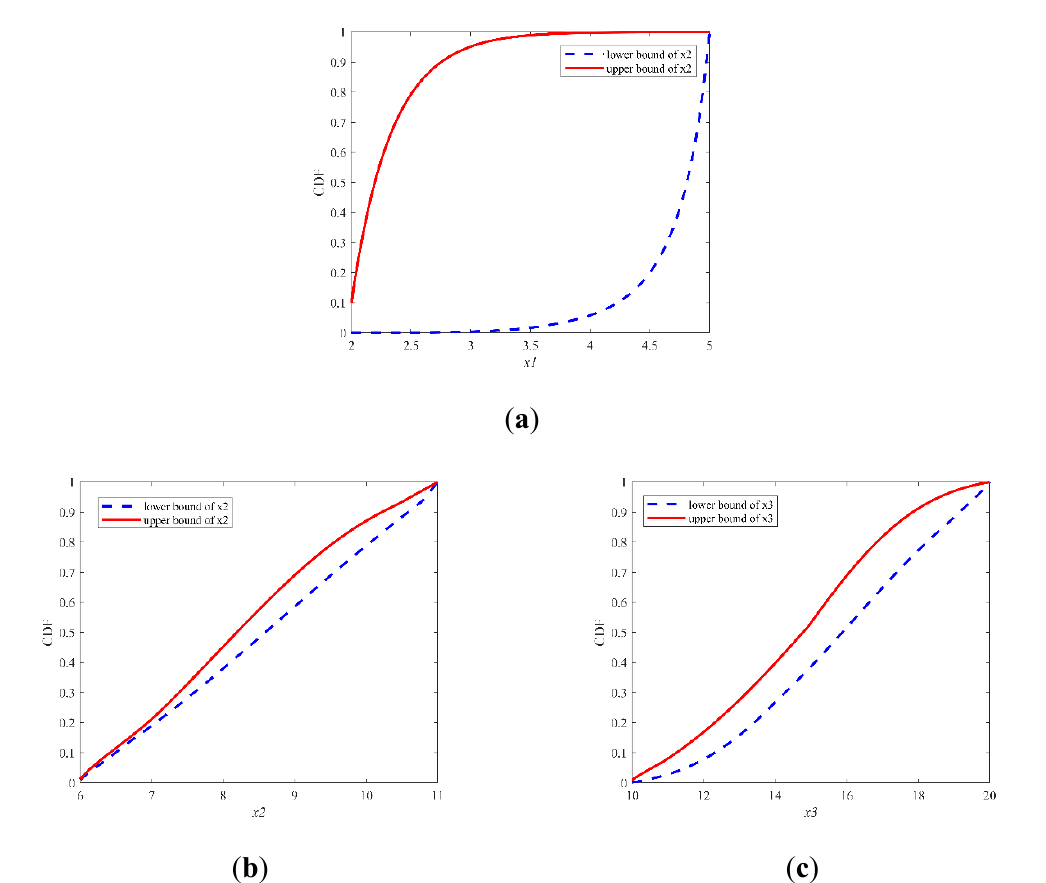
x ; ( b ) probabilistic Figure 8. ( a ) Probabilistic representation of epistemic uncertain variables Figure 8. ( a ) Probabilistic representation of epistemic uncertain variables x 1 ; ( b ) probabilistic 1 x ; ( c ) probabilistic representation of epistemic representation of epistemic uncertain variables representation of epistemic uncertain variables x 2 ; ( c ) probabilistic representation of epistemic uncertain 2 variables x 3 . x ; uncertain variables 3